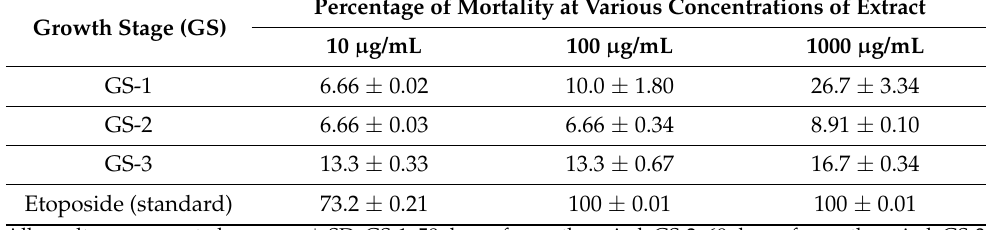
Table 2. Brine shrimp lethality assay for O. basilicum leaf aqueous extracts.